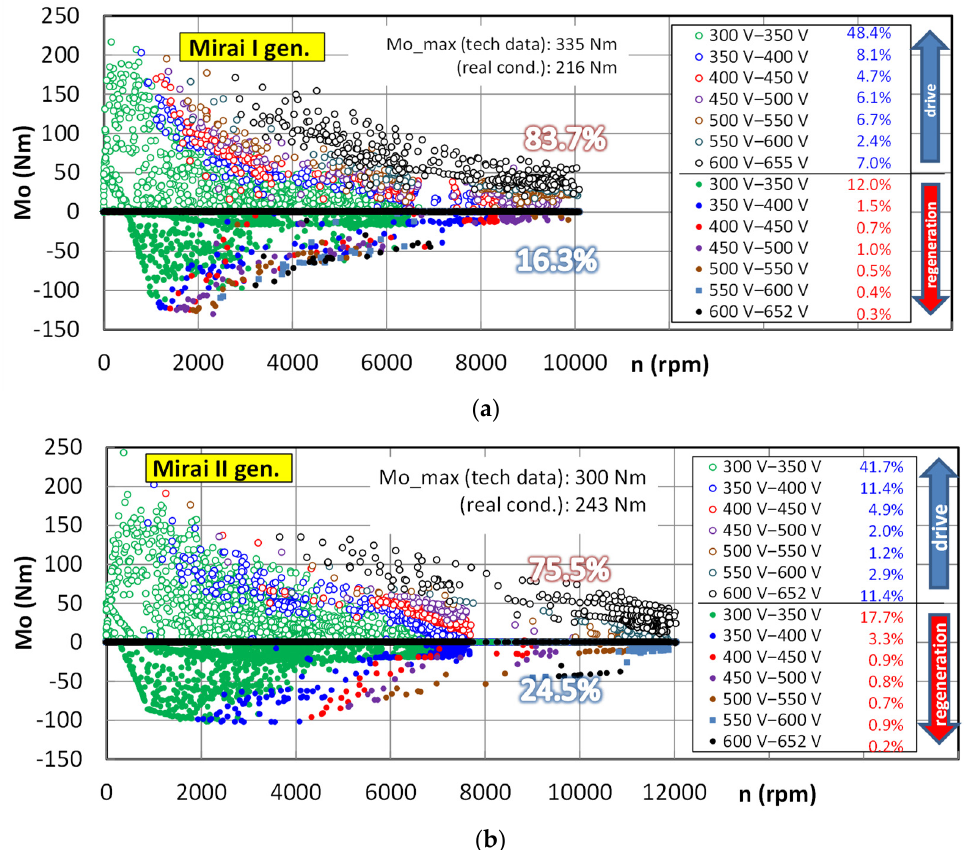
Figure 12. Electric motor characteristics (propulsion and regenerative braking) with supply voltage ranges and operating time density: ( a ) first-generation drive; ( b ) second-generation drive.